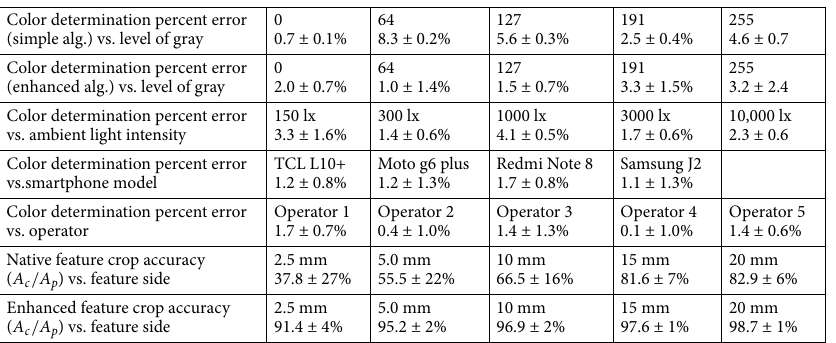
Color determination percent error (simple alg.) vs. level of gray Color determination percent error (enhanced alg.) vs. level of gray Color determination percent error vs. ambient light intensity